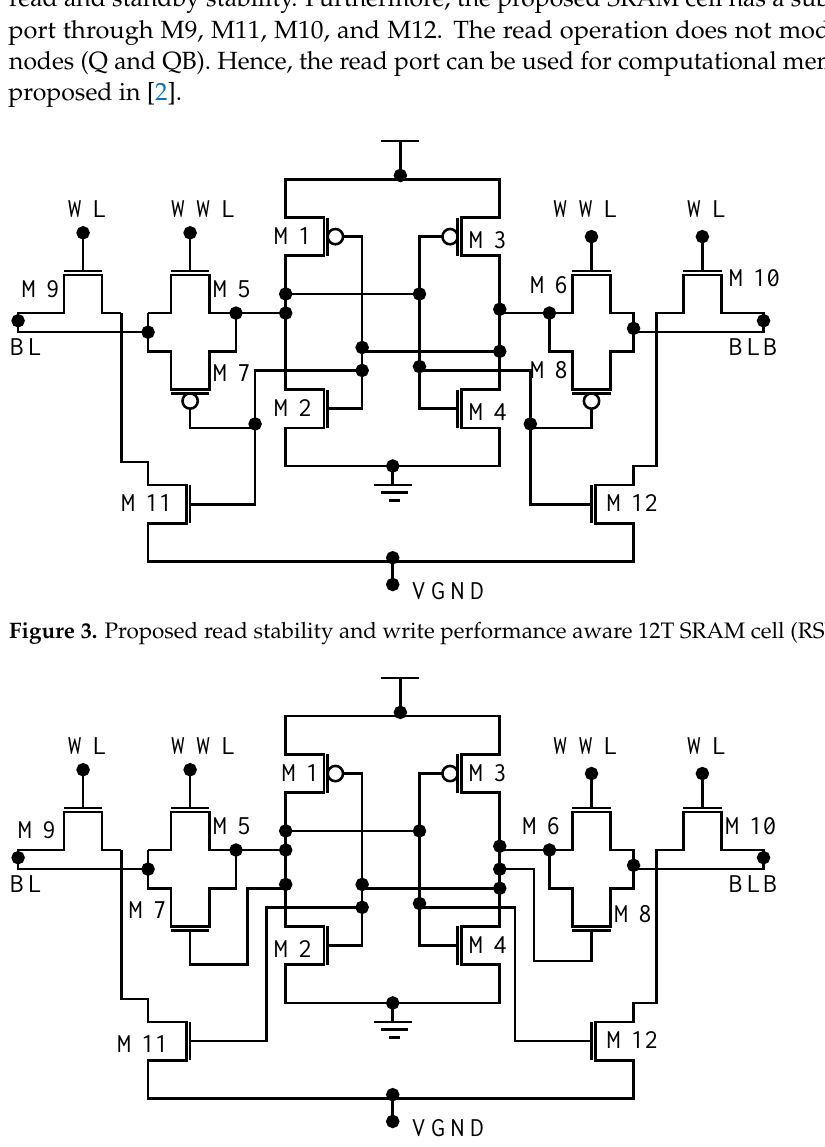
Figure 4. Proposed read stability and write performance aware 12T SRAM cell using NMOS transis- tors